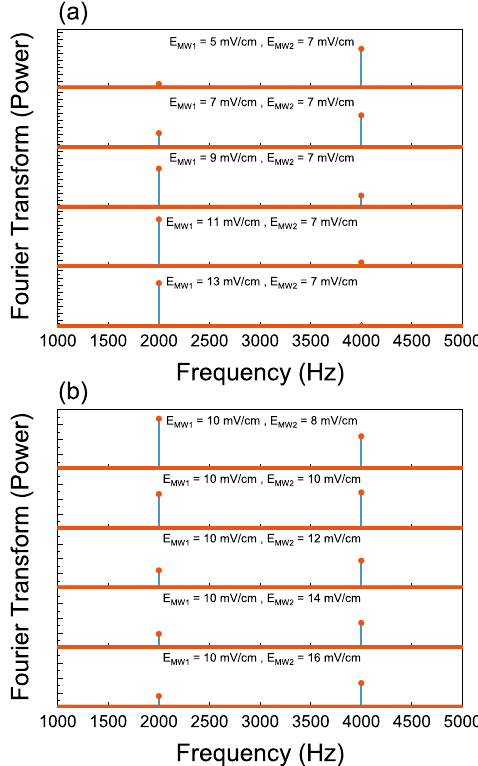
Figure 3. The power spectrum of fast Fourier transform of the photoelectric signal accepted by the Rydberg atom-based receiver in the condition of various pairs of MW E-intensities. ( a ) The increasing of the MW1 power enhances the signal amplitude of its own channel, until E MW1 ∼ 11 mV/cm, but weakens its opponent always gradually. ( b ) Similar to ( a ), but the turning point occurs at E MW2 ∼ 10